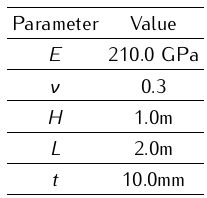
Table 1. Plates materials properties and